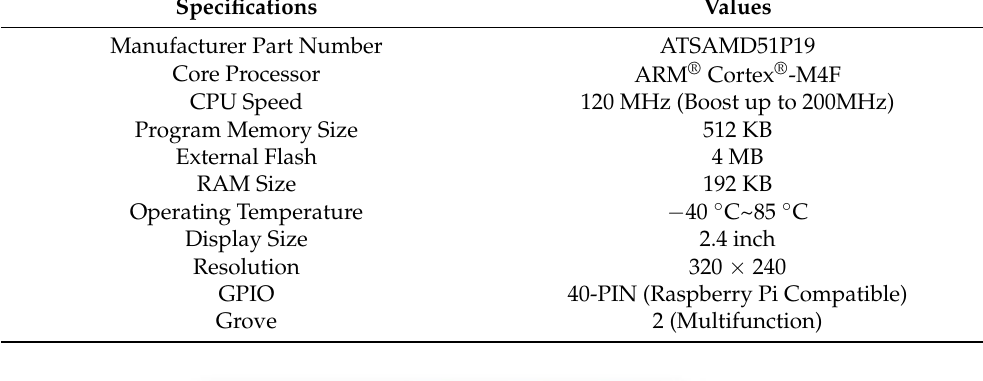
Figure 6. Hardware overview of the Wio terminal.